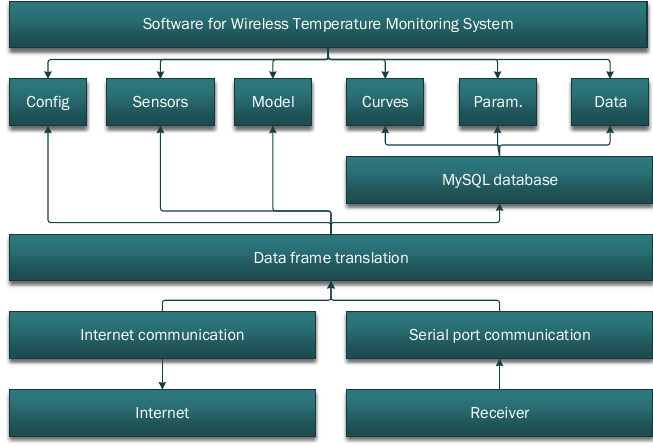
Figure 11. Software